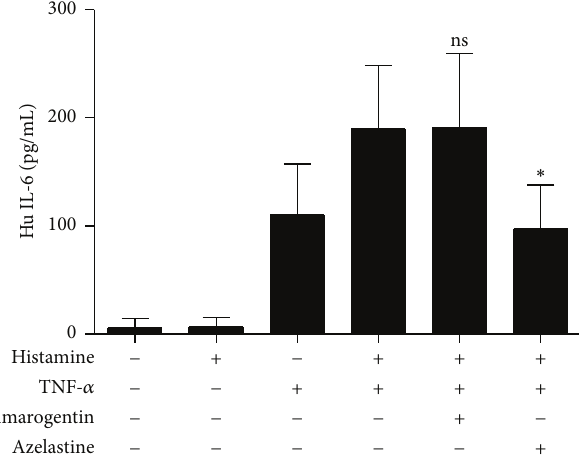
Figure 2: Impact of amarogentin on IL-6 secretion in stimulated HaCaT keratinocytes. HaCaT cells were costimulated with 100 𝜇 M histamineand25 ng/mLTNF- 𝛼 andpreincubatedwithamarogentin (100 𝜇 M) or the control azelastine (24 𝜇 M) for 30 minutes. After 24 h IL-6 expression was assessed in the cell supernatant. The data are shown with standard deviation (SEM) and were analyzed with the unpaired, two-tailed 𝑡 -test ( ∗ 𝑝 < 0.05 ; ns: not statistically signifi- cant; 𝑛 = 3